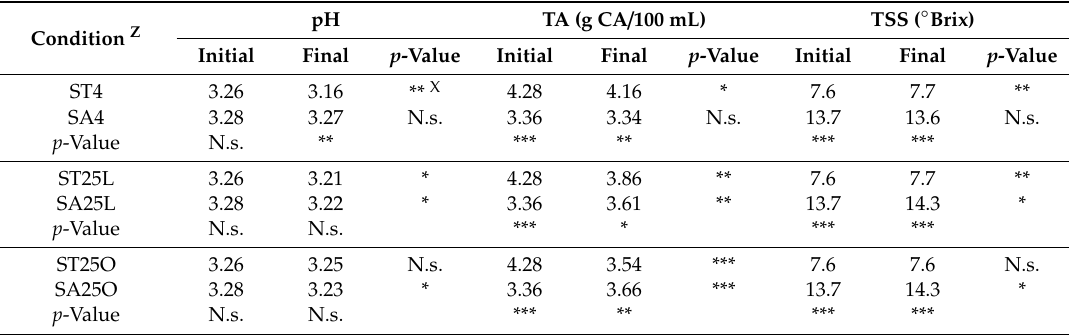
Table 2. pH, titratable acidity (TA), and total soluble solids (TSS) values, measured at day 0 (initial) and after 90 days storage (final), for juices with added stevia or sucrose as sweeteners and stored under three different conditions.